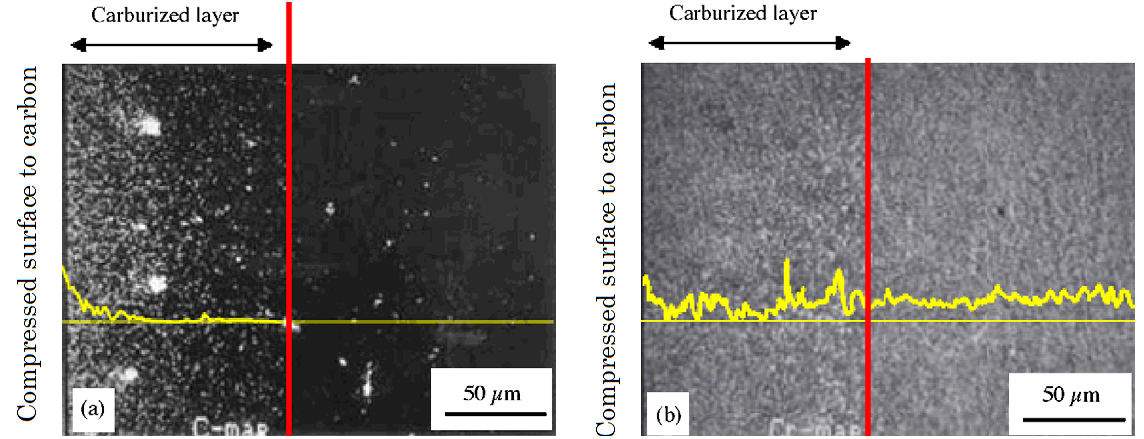
Figure 7. Concentration mapping for Carbon ( a ) and Chromium ( b ) obtained by auger electron spectroscopy of the vertical cross-section of compression side faces of SPDSS carburized at 1273 K for 30 min under 3 MPa. The bold yellow lines in figures are line analysis results for each element [12].